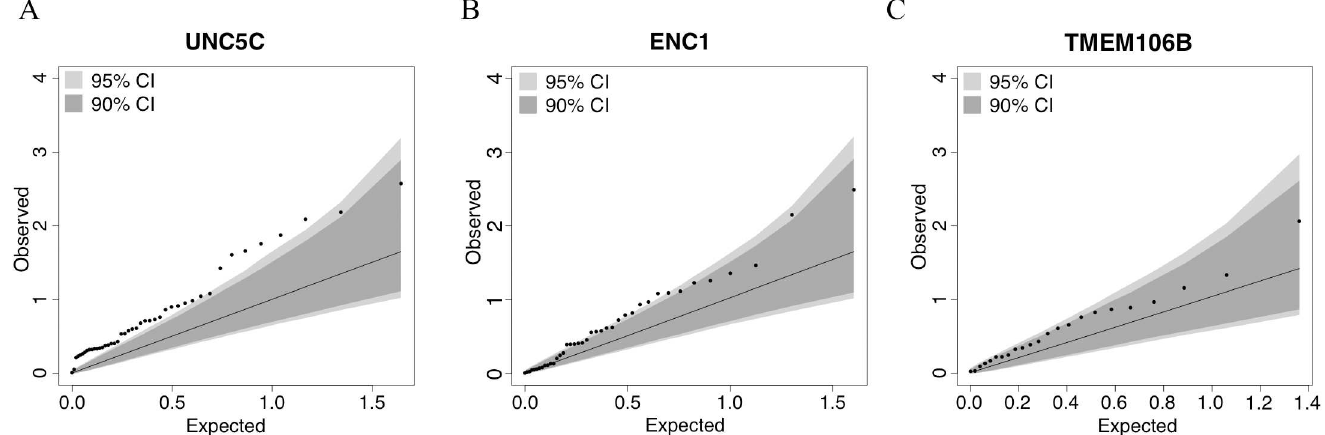
Fig 3. Quantile–quantile plots for the association of residual cognition and DNA methylation pattern in UNC5C , ENC1 , and TMEM106B regions. Each panel presents the results of the DNA methylationanalysisof one of the three tested regions: (A) UNC5C , (B) ENC1 , and (C) TMEM106B . The omnibusanalysisassesses the level of evidenceof association for the entire region; here, we illustrate the results by plotting the associationstatistic for each CpG (dots) comparing the observed p- valueto the value expectedfrom a null distribution.The dark gray area in each plot denotesthe 90% confidenceinterval, and the light gray area denotesthe 95% confidence interval. The functionalunit of methylationis not a single CpG but rather a methylated region, and we see that the ENC1 and UNC5C regions demonstrate a level of associationthat is globallydifferent from what one would expect by